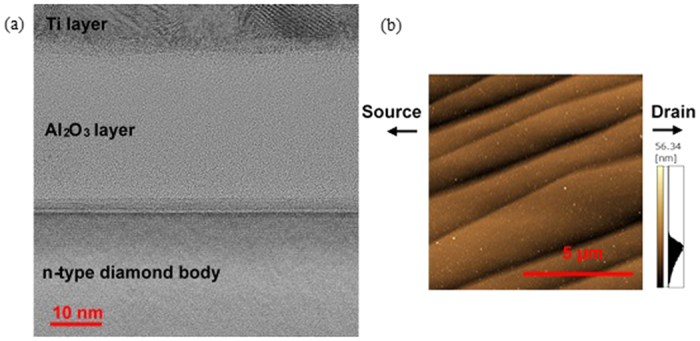
(a) TEM image of Al2O3/diamond interface. (b) AFM image of surface of n-type diamond body.